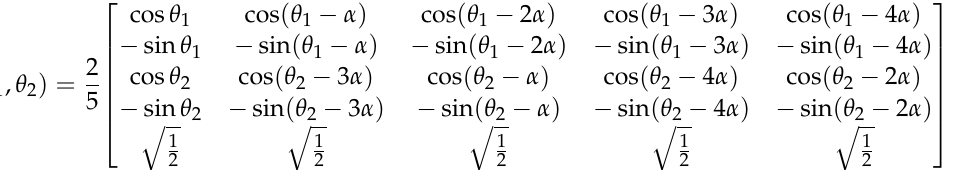
Figure 7. Double SIN − FPMSMS series control based on DFV − SVPWM. Figure 7 shows the block diagram of two SIN − FPMSMs in series based on decoupling control. The transformation matrix in the Figure 7